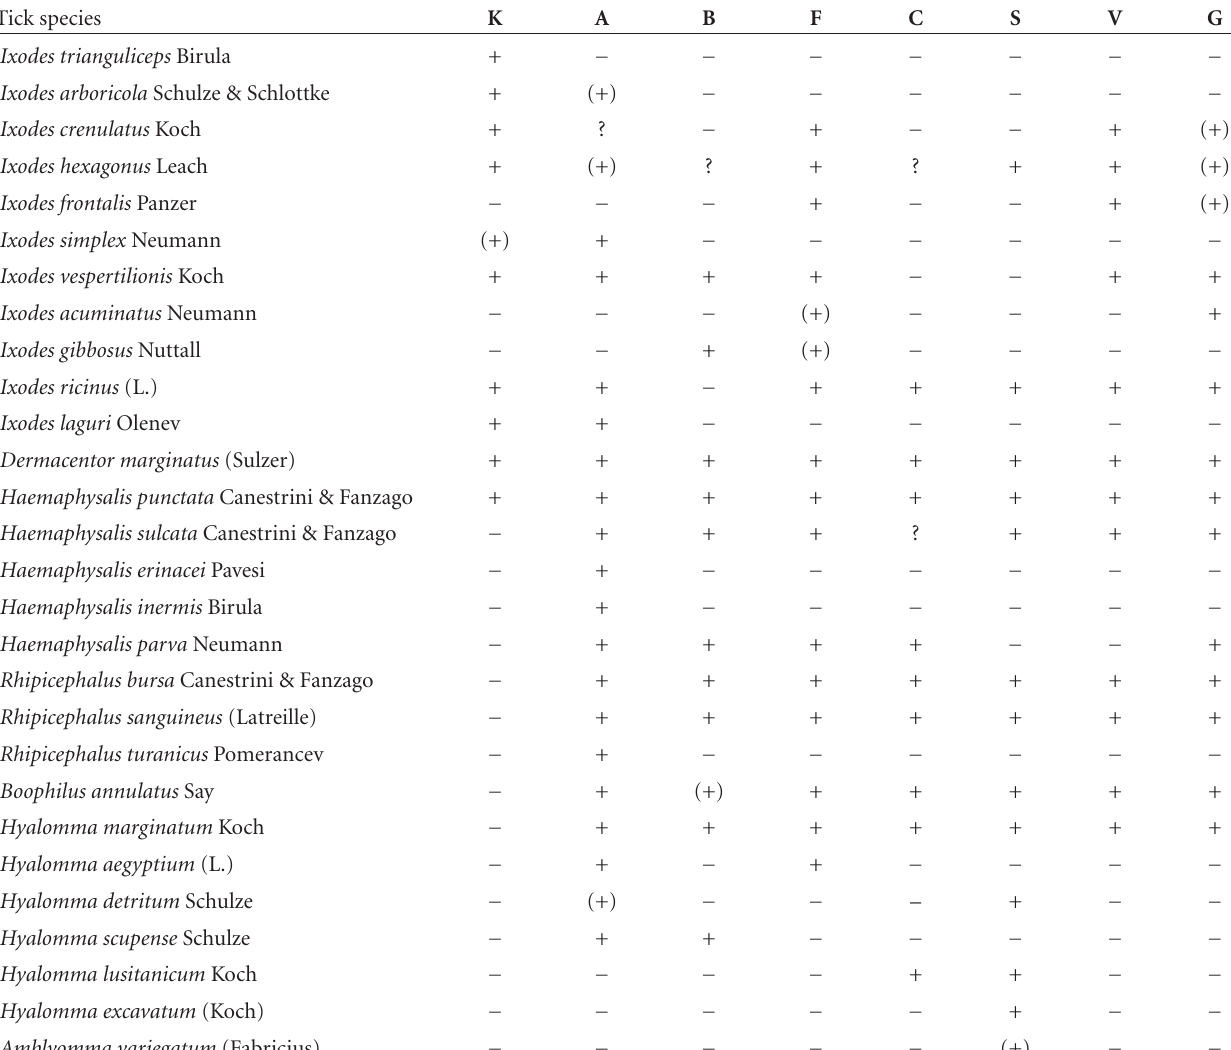
Table 1: Checklist of ixodid fauna in eight European BHAV areas (example of one of the three checklists of biota, viz Ixodidae , Vertebrata , and Tracheophyta